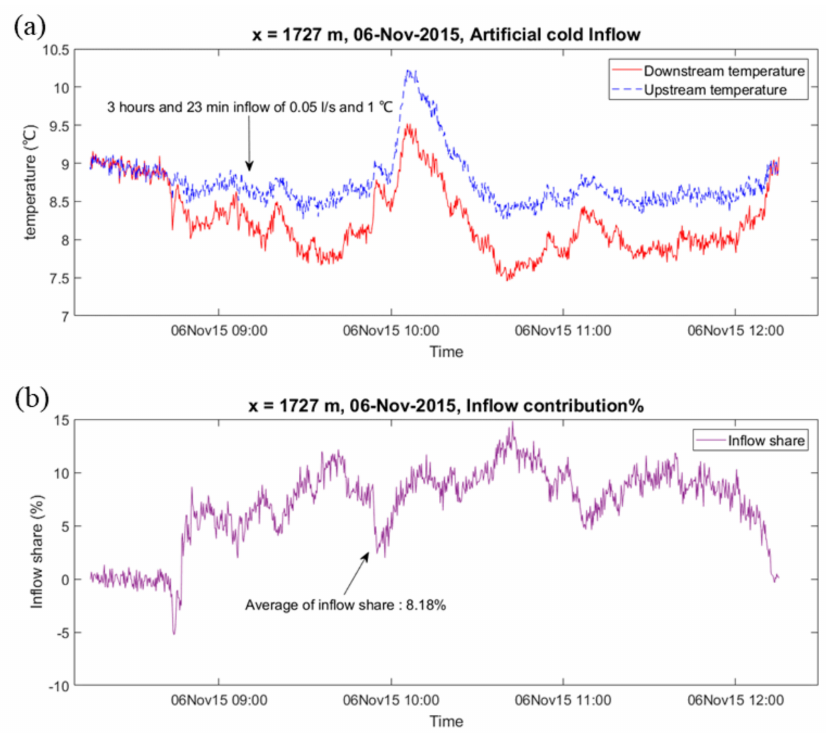
Figure 6. ( a ) Upstream and downstream temperatures on 6 November 2015 around cold artificial discharge in location x = 1727 m; ( b ) percentage of inflow share in comparison with the upstream flow.